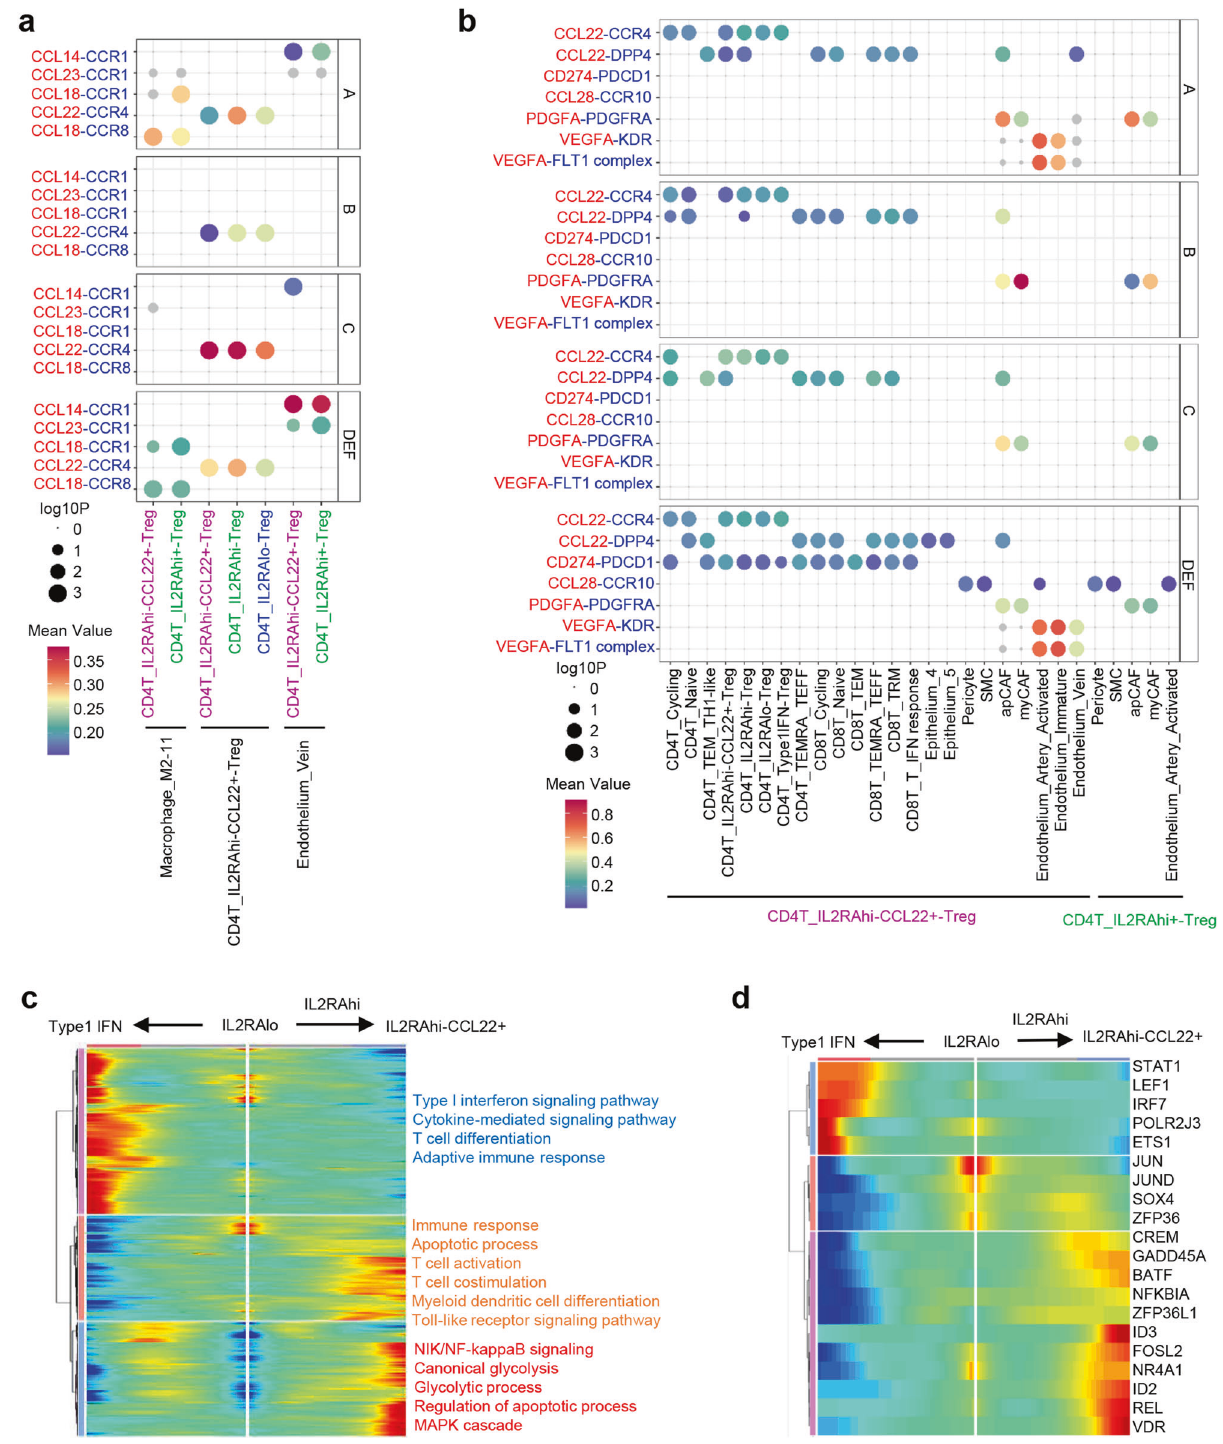
Fig. 6 Analysis of cell communication and CD4 + Treg cell transition states in pre-NACT and post-NACT tumors. a Dot plots showing chemokine-receptor communication between distinct cell types and Treg subtypes in the pre-NACT and post-NACT tumor microenvironment. b Dot plots showing ligand-receptor pair analysis of the interactions between IL2RAhi-CCL22 + -Treg or IL2RAhi- Tregs and distinct cell types in the pre-NACT and post-NACT tumor microenvironment. c Heatmap showing the dynamic changes in gene expression along the pseudotime. The enriched pathways are labeled by colors. d Heatmap showing the dynamic changes in transcription factor expression along the ef fi cient therapeutic targets represent the major obstacles in DISCUSSION improving OS rates. Recurrent tumors are often treated based on Despite the progress made in treatment strategies, the clinical the pathological characteristics of the primary tumor. However, outcomes of advanced HGSCs remain dismal. The high incidence whether the recurrent and primary tumor share a similar of early recurrence, resistance to therapeutics, and the lack of